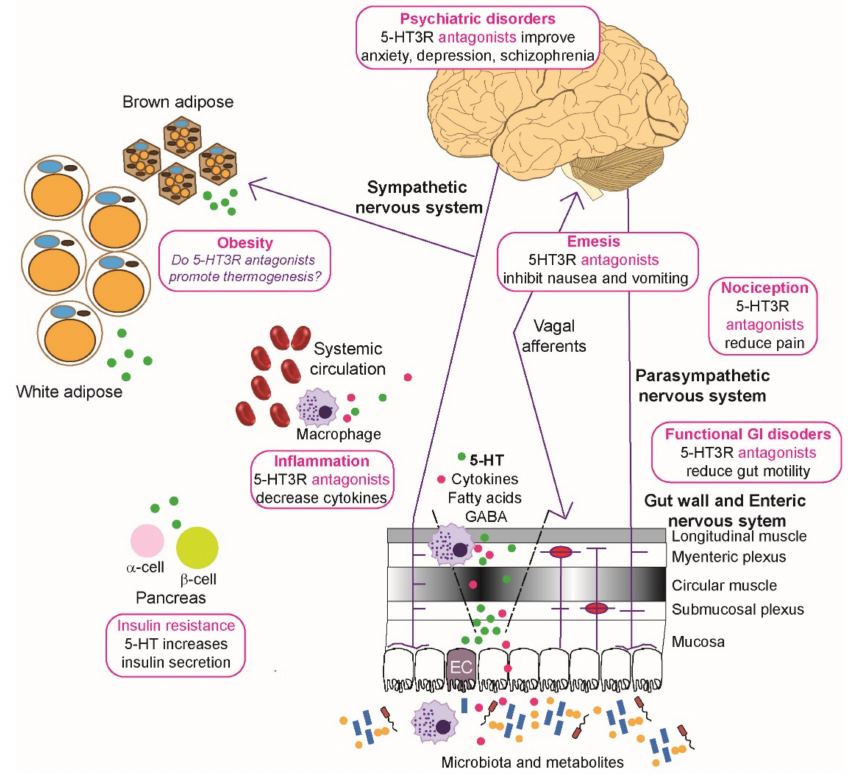
Figure 3. Roles of 5-HT 3 receptors in diseases and metabolic disorders. Microbiota and their metabolites present in the lumen of the gut can affect the epithelial cells and any dendritic cells to modulate local immune function and induce enterochromaffin (EC) cells to secrete serotonin (5-HT, shown as green circles) that enters the circulation. Visceral stimulation via the sympathetic nervous system induces production of serotonin by EC cells. The enteric nervous system, consisting of submucosal plexus underneath the epithelial cells lining, interacts directly with layers of the gut wall and parasympathetic, spinal, and vagal nerves to enable bidirectional communication with the central nervous system. 5-HT release from the ECs activates 5-HT 3 receptors on enteric neurons, vagal and spinal afferents, and these in turn relay input to the dorsal root ganglia and the brain stem. Overactivation of the chemoreceptor complex in the brainstem can lead to emesis and the processes also contribute to functional gastrointestinal (GI) disorders, such as irritable bowel syndrome, and nociception. Neuropsychiatric disorders like depression and schizophrenia are affected by disturbed 5-HT 3 receptor signaling in the limbic region of the brain. Increased circulatory 5-HT is associated with increases in production of cytokines (shown as magenta circles), and sometimes nociception. In addition, these circulatory changes in 5-HT can potentially modify adipose function where brown adipose cells decrease thermogenesis normally raised by sympathetic activation, although this has mainly been studied using rodent models. By activating 5-HT 2 and 5-HT 3 receptors, 5-HT in the pancreas enhances ß cells to secrete more insulin, which acts on α cells to inhibit glucagon secretion. Physiological levels of 5-HT released by ß cells in response to glucose also lead to decrease in glucagon secretion and this effect is mediated by 5-HT 1 receptor on α cells. For further details see the text (Sections 5 and 6). Image drawn in Adobe Illustrator with brain image created by Hugh Guiney (CC BY-SA 3.0 https://creativecommons.org/licenses/by-sa/3.0, accessed on 25 October 2021), via Wikimedia Commons (https://commons.wikimedia.org/wiki/File:Human-brain.SVG, accessed on 25 October 2021) and red blood cells (https://commons.wikimedia.org/wiki/File:Blausen_0761 _RedBloodCells.png, accessed on 25 October 2021) created by